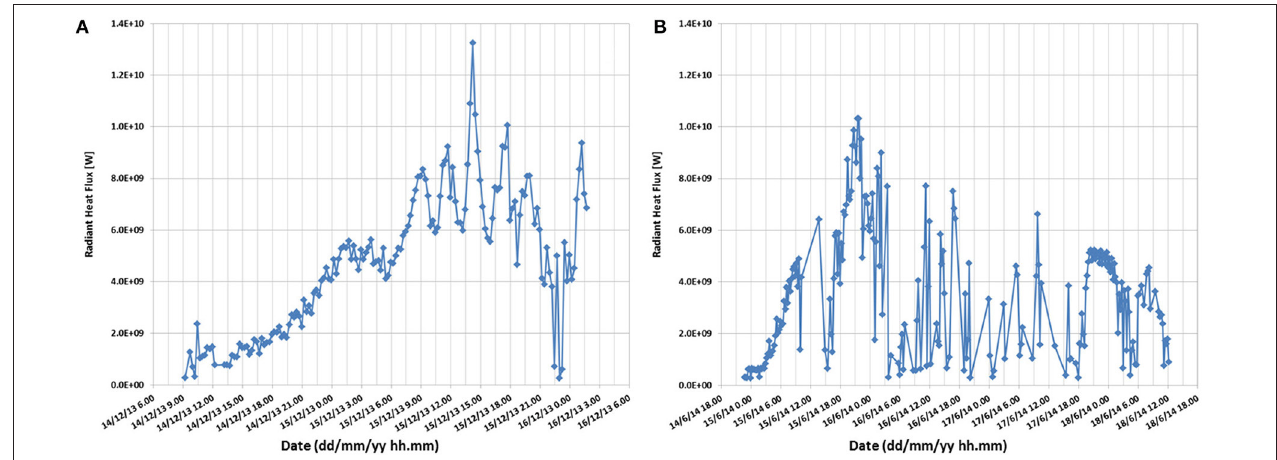
FIGURE 4 | Radiant heat flux curves of the eruptive episodes occurred on 15 December 2013 (A) and 16 June 2014 (B) . It is noteworthy the change in the radiant heat flux waveform, characterized by an increase of the event duration and a lack of the cooling phase, possibly related to a Strombolian activity.